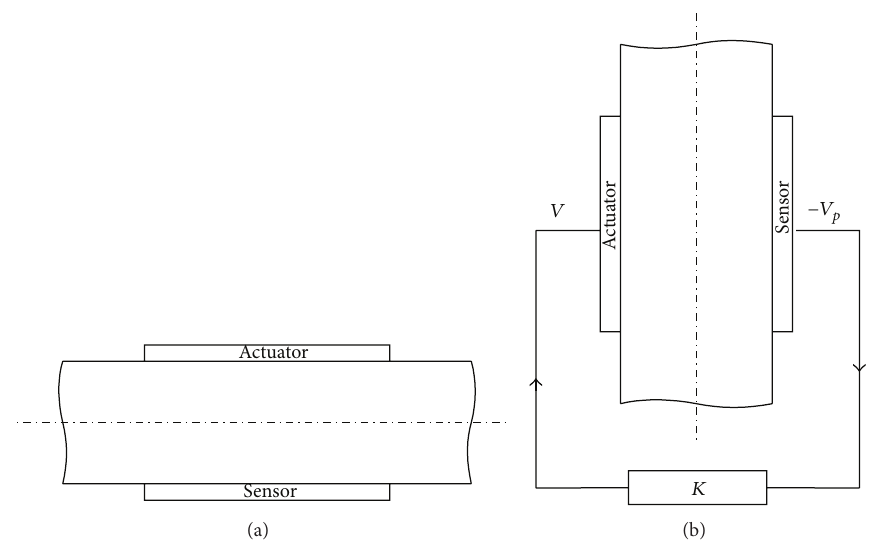
Figure 2: Scheme of an elastic structure controlled by means of coupled piezoelectric sensor and actuator.